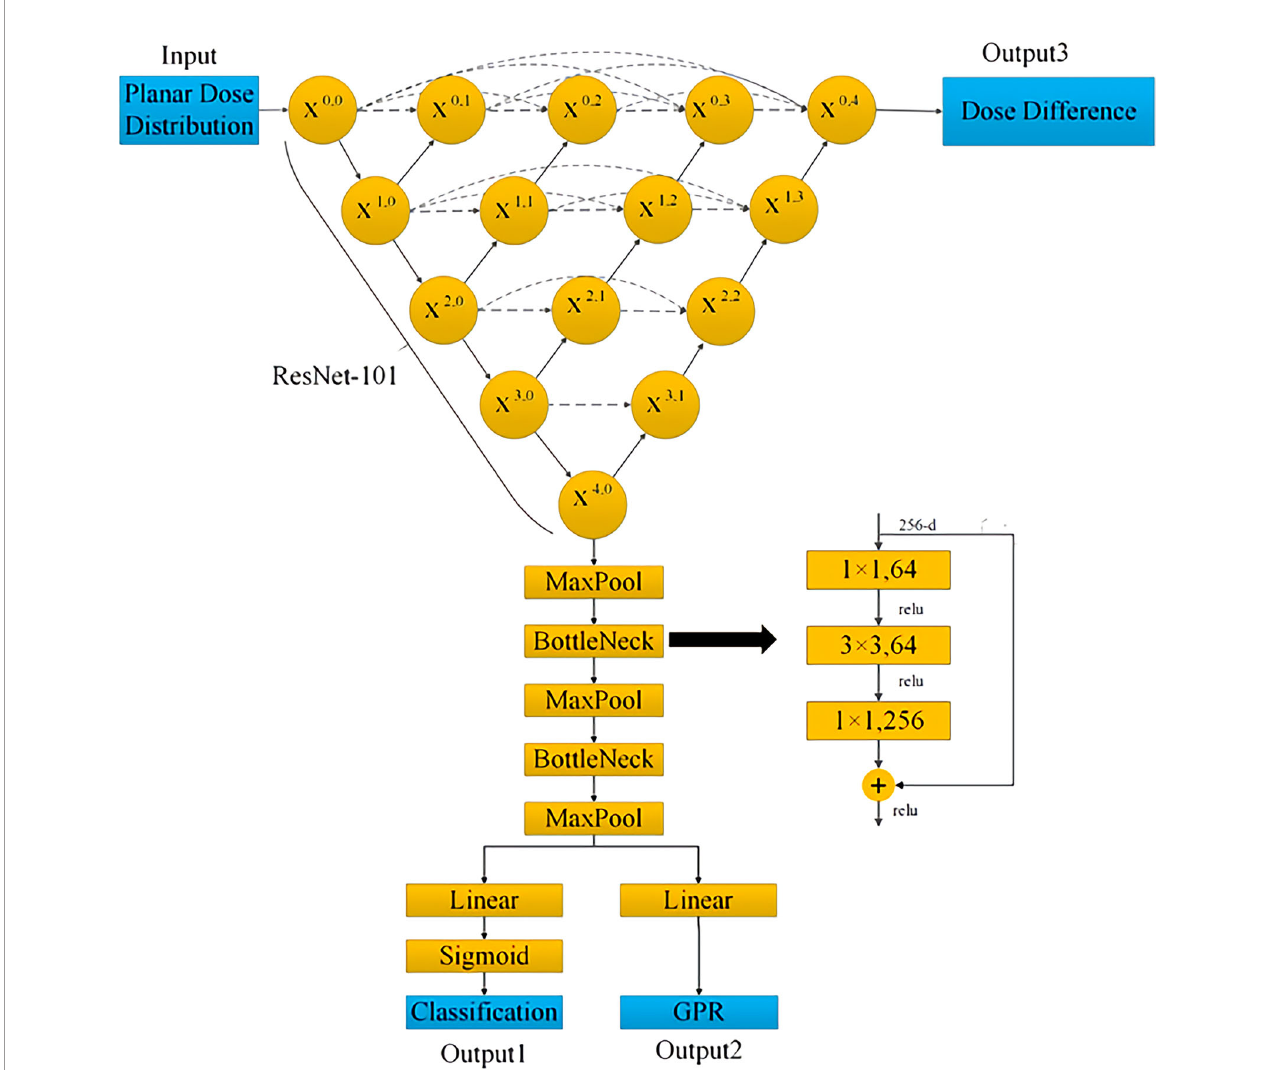
FIGURE 1 | Architecture of the UNet++ used for prediction